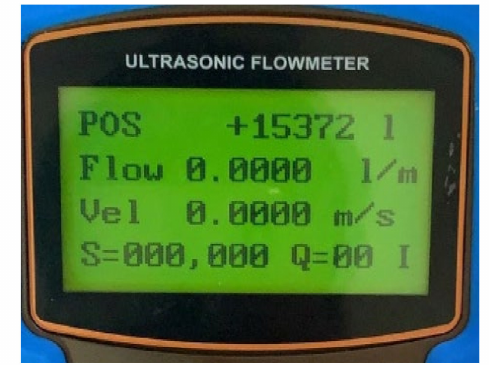
Figure 8. Ultrasonic